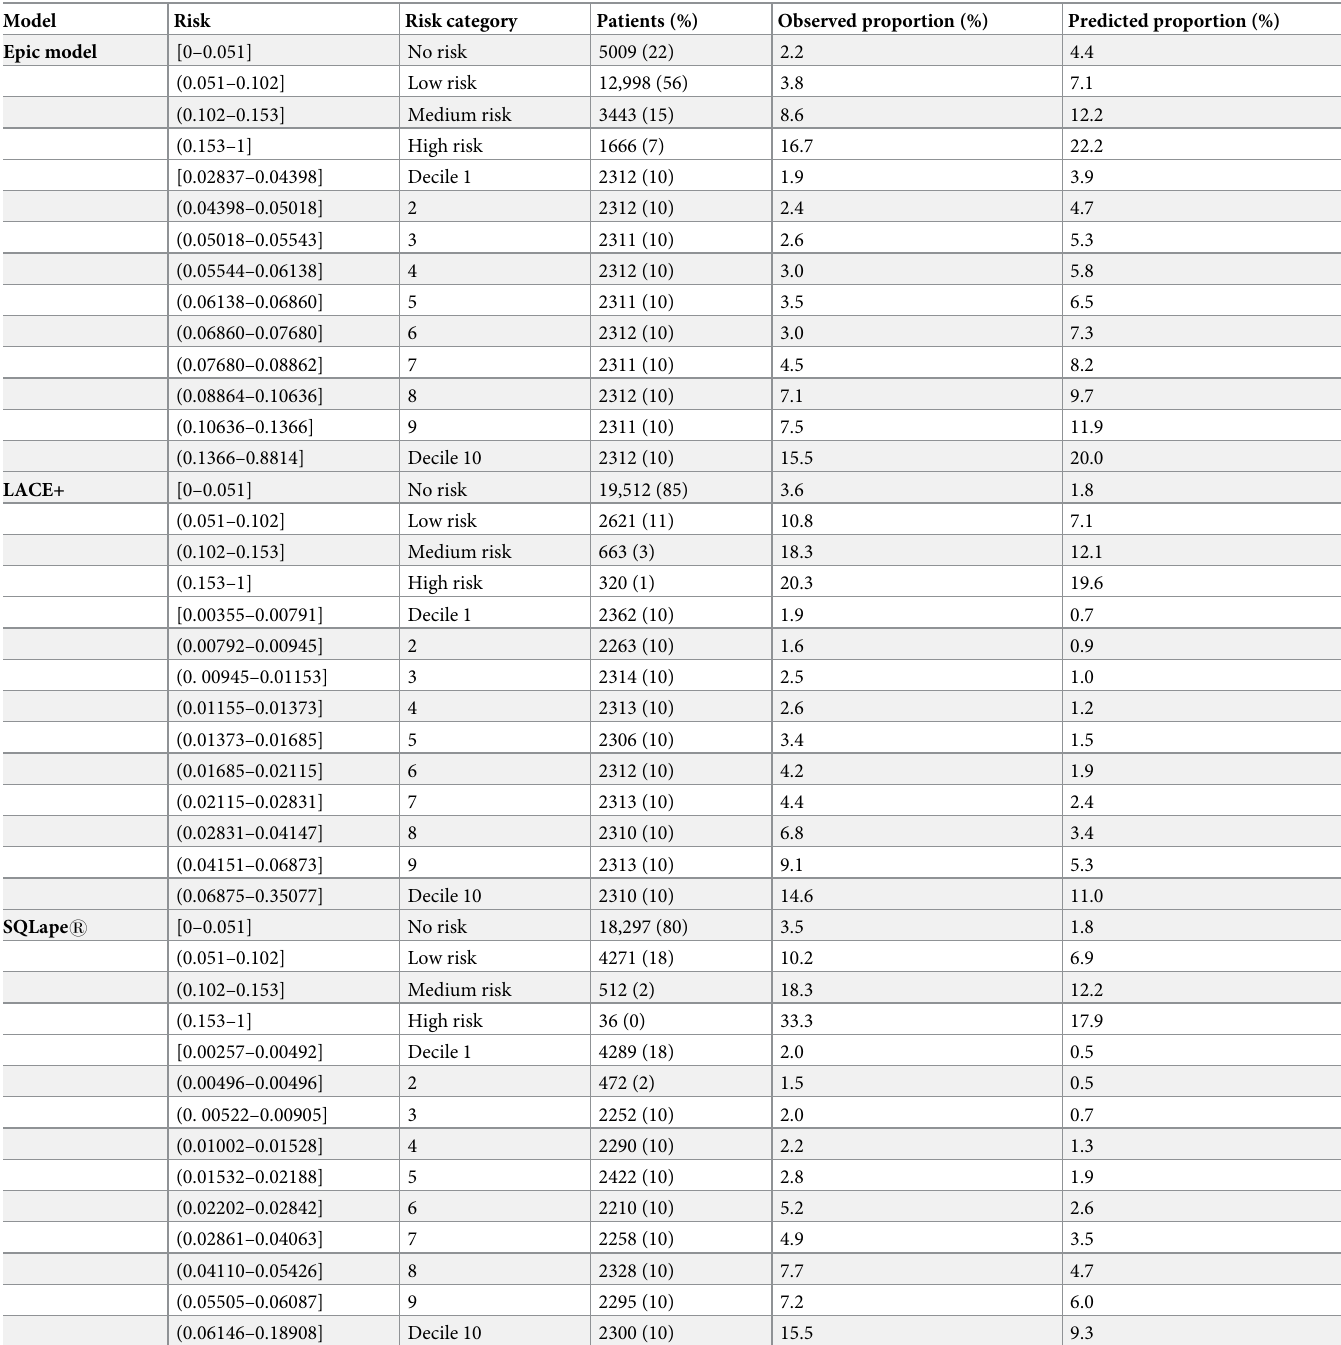
Table 6. Observed vs. predicted 30-day unplanned readmissions.